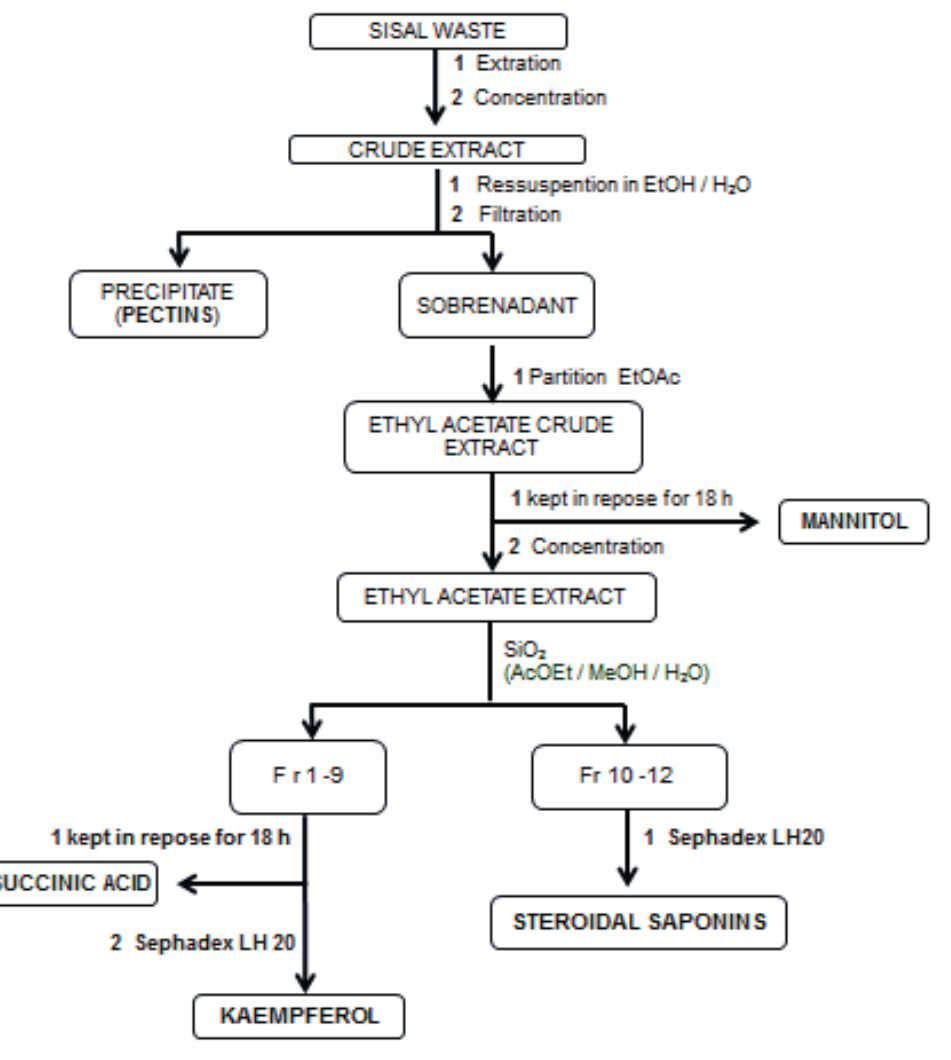
Figure 2. Scheme to obtain chemicals from sisal